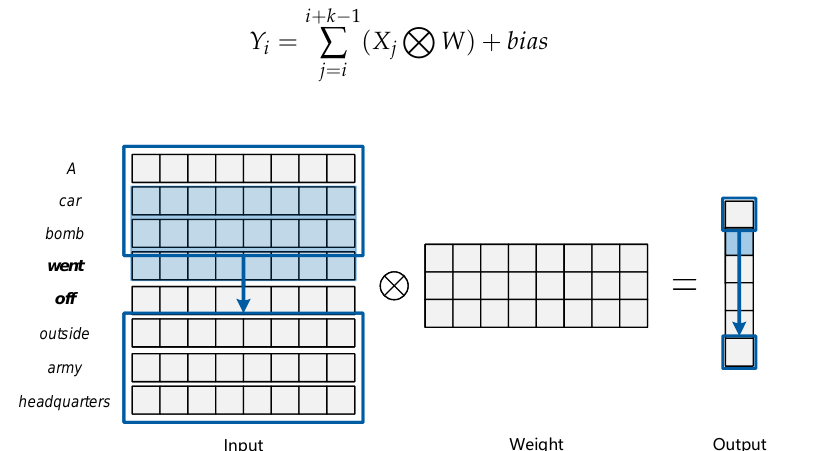
Figure 1. Two-dimensional (2-D) convolution operations: applying 2-D convolution on a sentence. When processing the Chinese corpus, each Chinese character has an embedding representation, just like an English